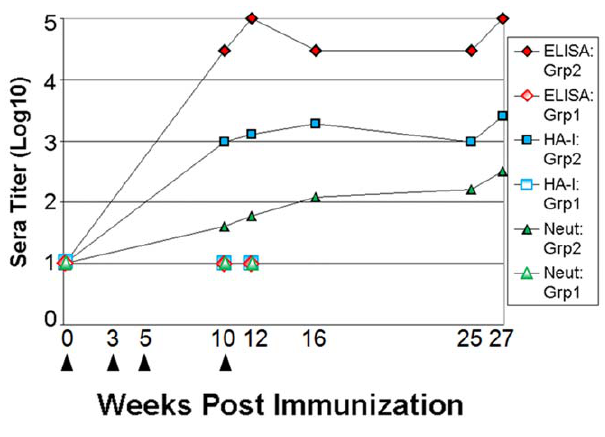
Figure 1. Immunological analysis of Guinea pig serum pools. Animals in Group 1 were inoculated with a mock preparation of antigen (open symbols) and then infected with homologous influenza A/ Wyoming/03/2003.Animals in Group 2were immunized withrecombinant HA compounded in Incomplete and Complete Freund’s adjuvant (solid symbols) prior to infection. Serum pools were assayed for antigen binding antibodies by ELISA against commercially prepared HA glycoprotein (diamond). Antiviral activities were measured by both hemagglutinin inhibition (square) and virus neutralization (triangle) assays. Arrows underneath graph indicate dates of inoculation. Immunized Guinea pigs were challenged with influenza virus on Week 25.